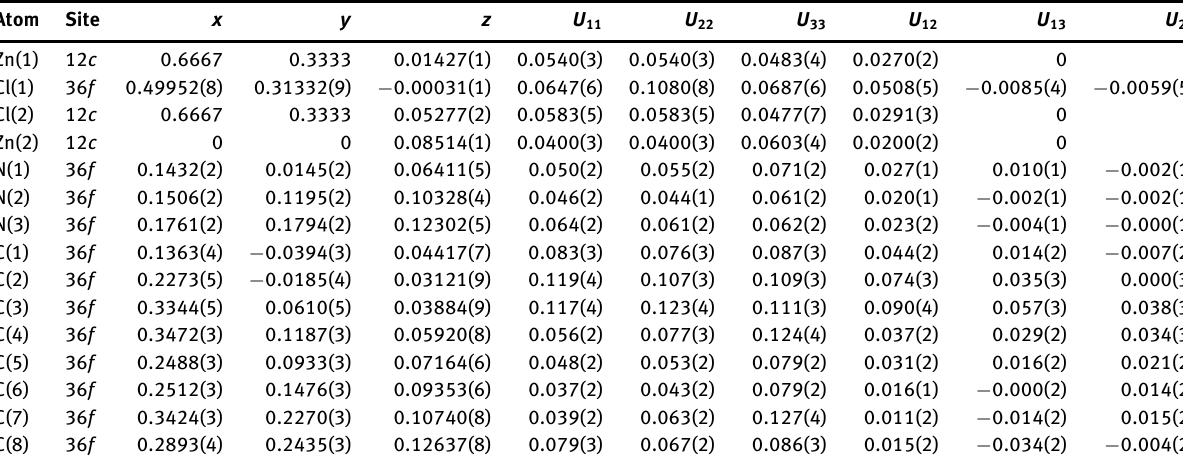
Table 3: Atomic coordinates and displacement parameters (in Å 2